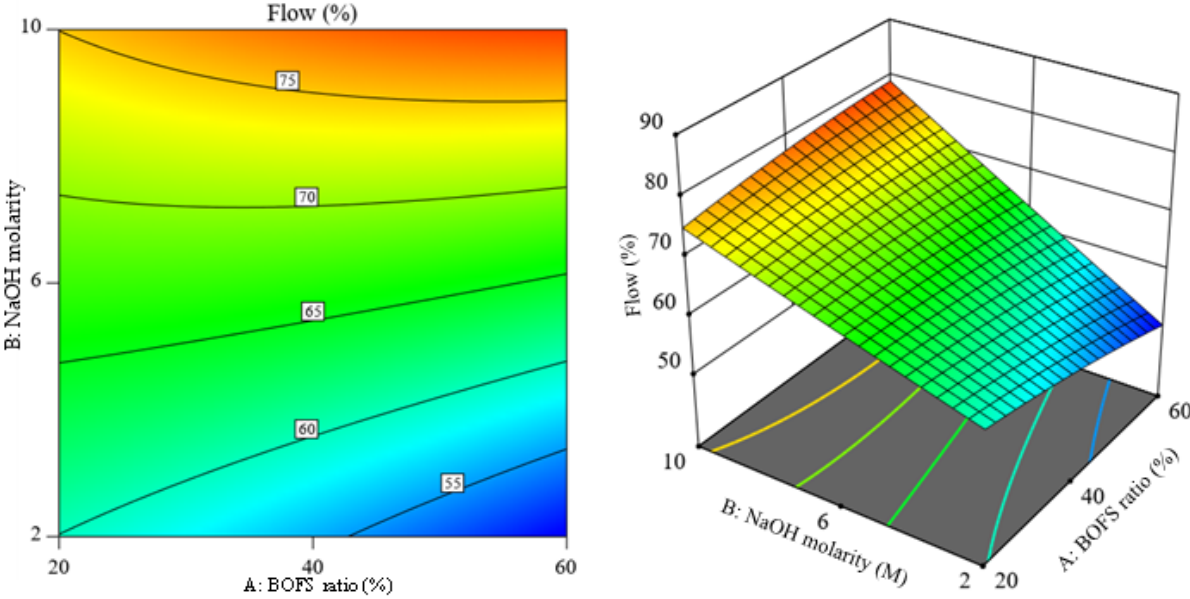
Figure 13. Contour plot and 3D response surface of flow values.